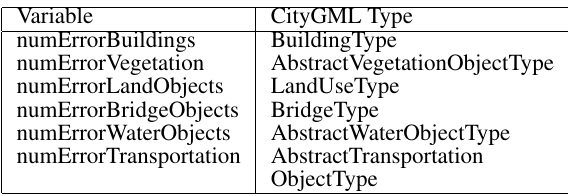
Table 2. CityGML Type to error variable mapping